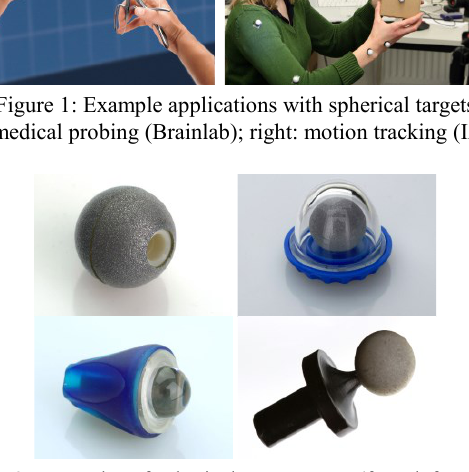
Figure 2: Examples of spherical retro-targets (from left to right: IZI, Atesos, NDI,